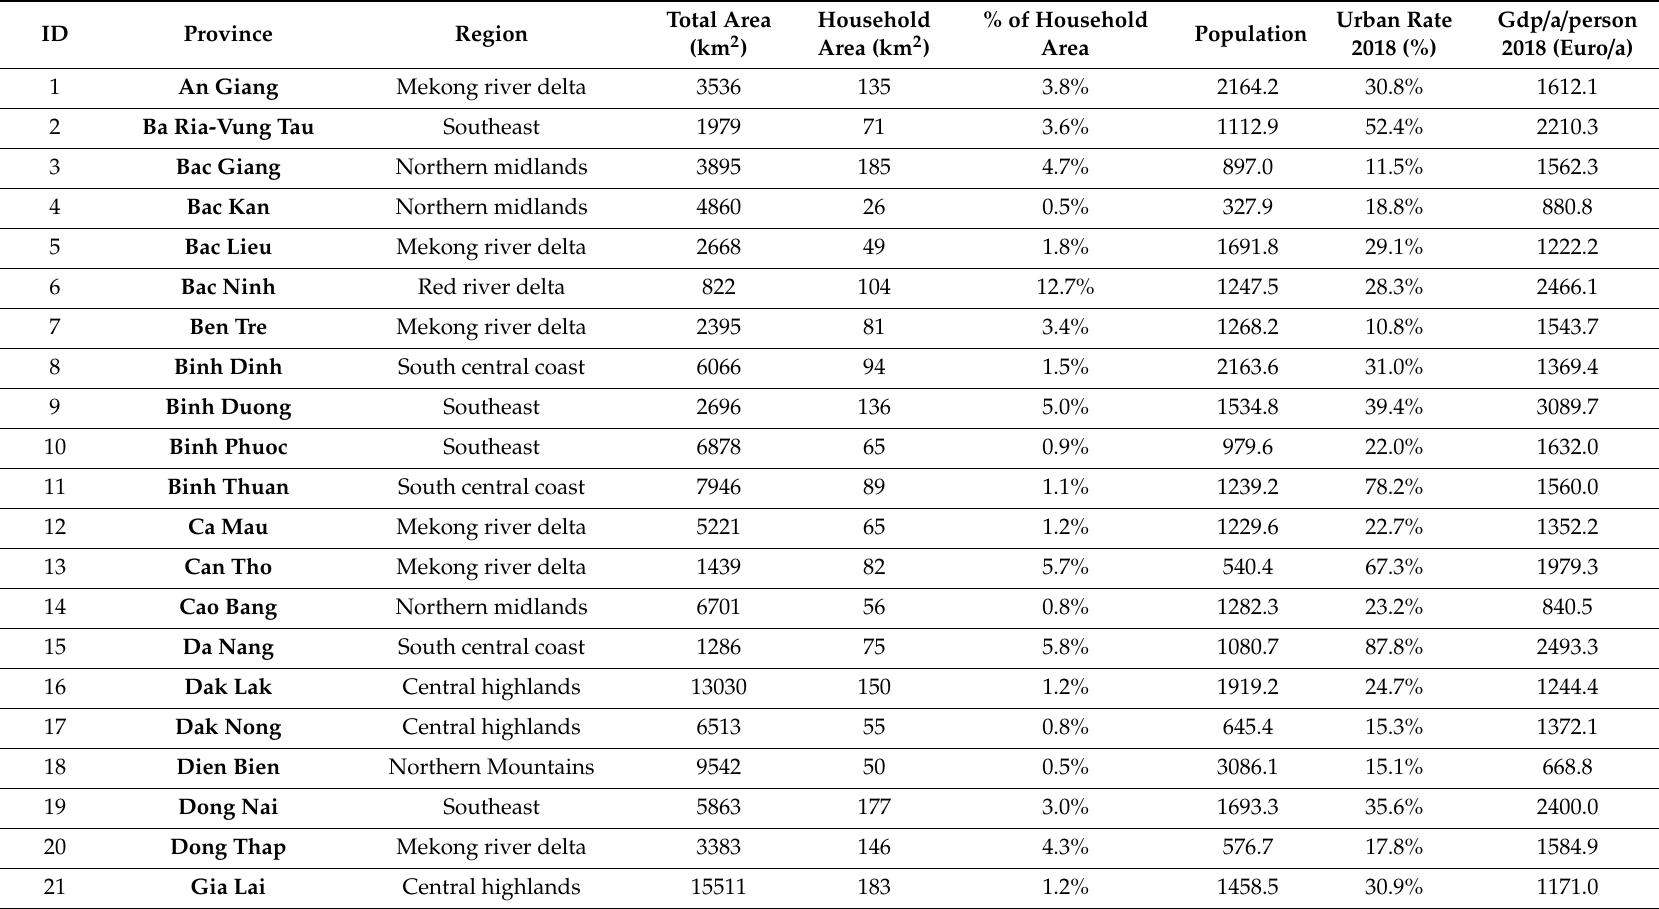
Table A2. Provinces in Vietnam and their demographic